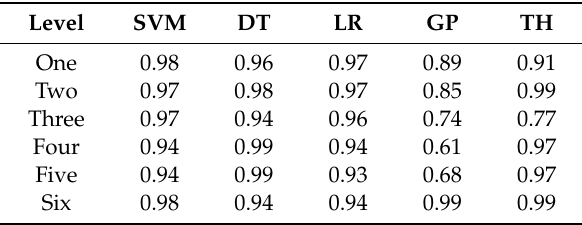
Table 12. Accuracy of di ff erent levels of three classification